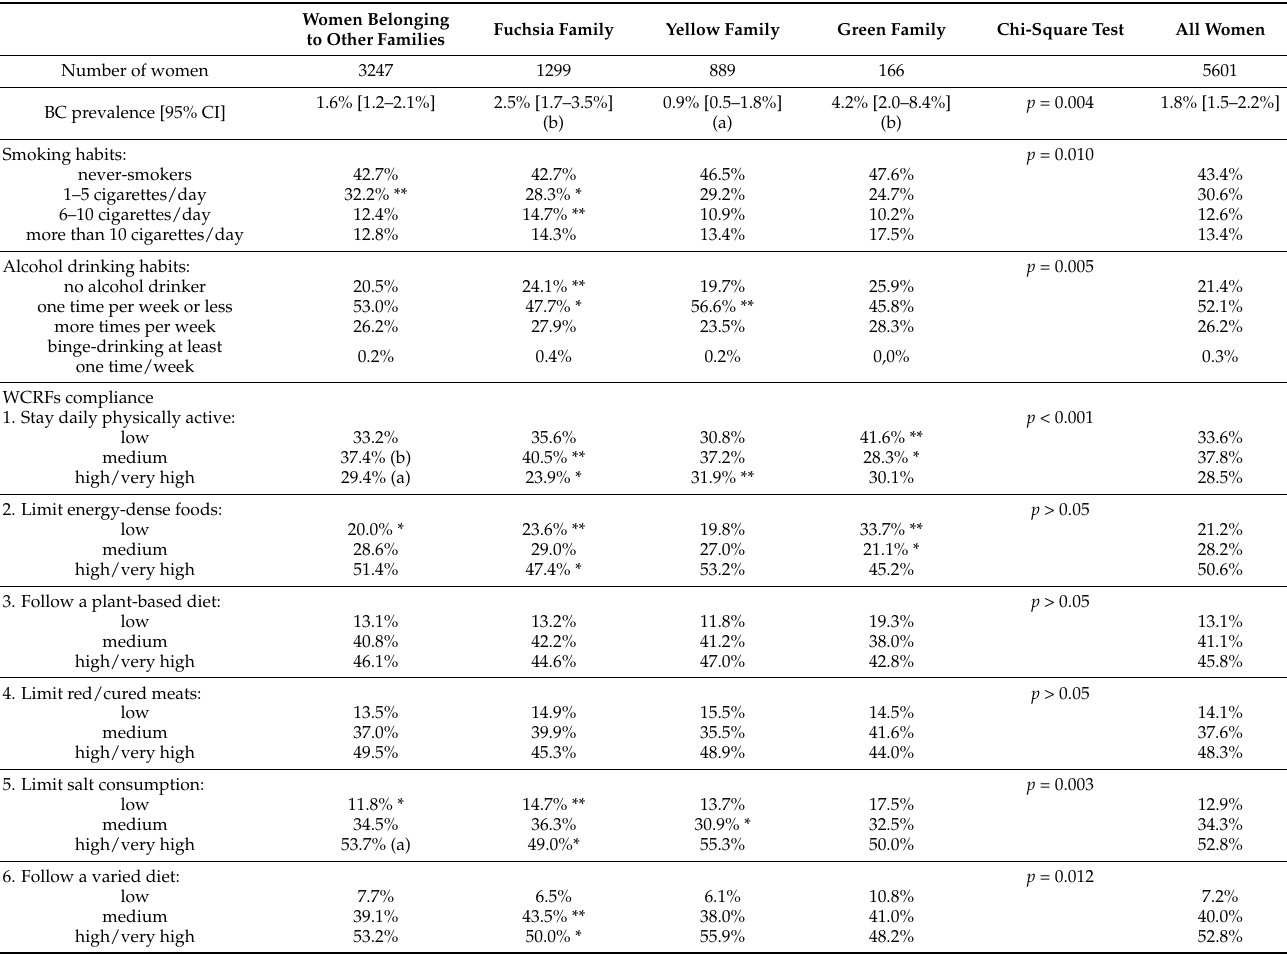
Table 3. Distribution of the characteristics included in the profile 3: overall population of women and focus on the families statistically associated with BC. See Section 3.4 for the description of the communities and the families. Women Belonging to Other Families Fuchsia Family Yellow Family Green Family Chi-Square Test All